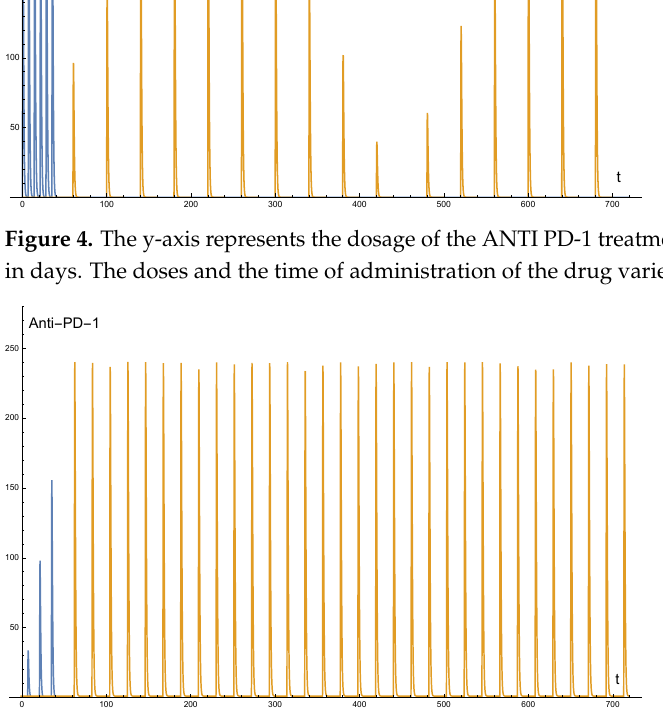
Figure 5. The y-axis represents the dosage of the ANTI PD-1 treatment and x-axis represents the time in days. At the first period of the treatment, the dosages varied in time, and at the second period of the treatment, the dosages were fixed.